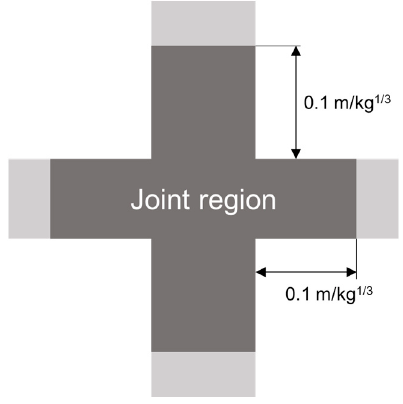
Figure 3. Joint region (Z = 0.1 m/kg 1/3 ).